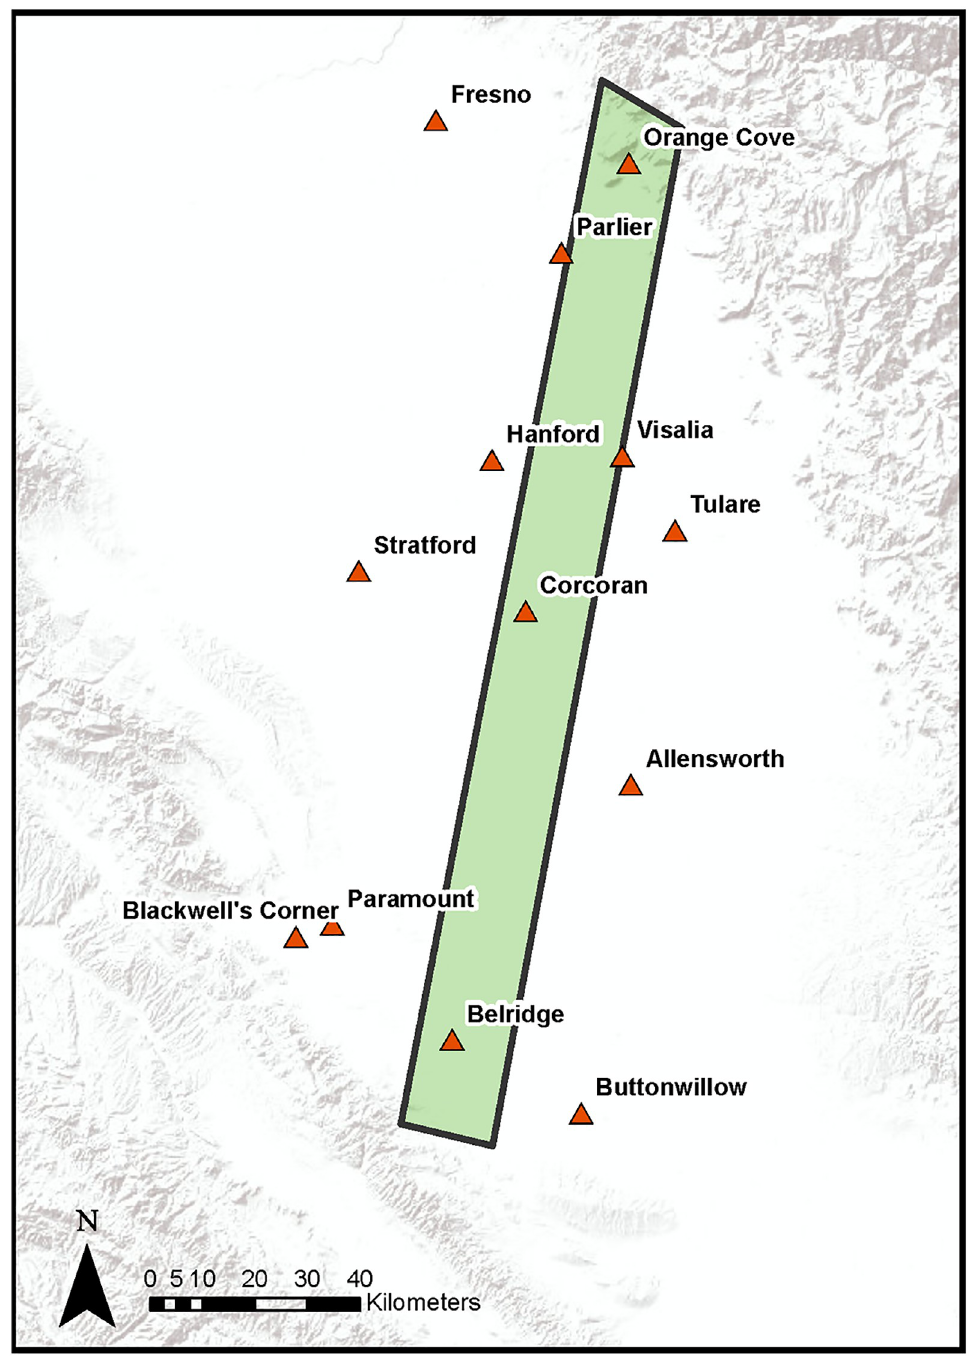
Fig 3. Meteorological stations used for wind speed and direction interpolation. Thirteen meteorological stations are shown in juxtaposition with the study site in light green. Basemap obtained from Esri ArcGIS. Sources: Esri, DeLorme, HERE,